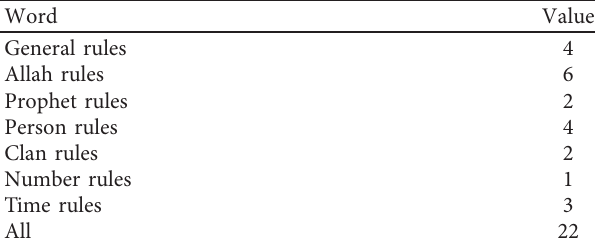
Table 10: Statistical information about new grammar